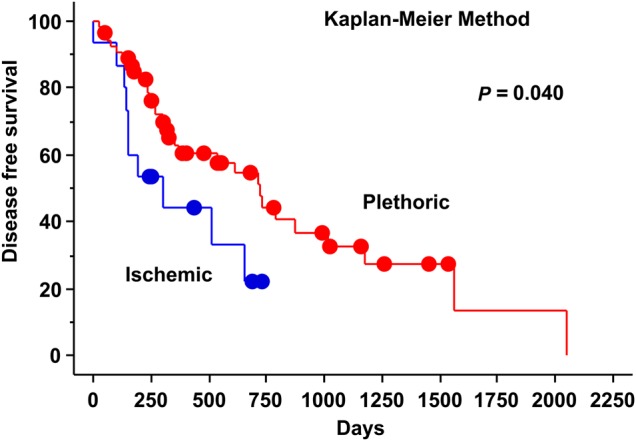
Progression-free survival curves by HCC type (hypovascular vs hypervascular).